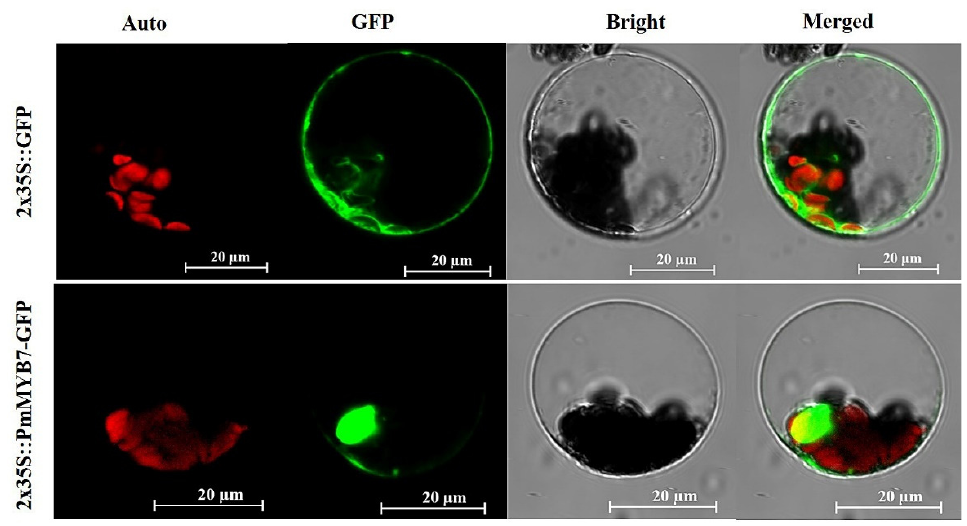
Figure 4. Subcellular localization analysis of 2x35S::PmMYB7-GFP in A. thaliana . The 2x35S::GFP was used as a control protein. Auto, chlorophyll autofluorescence; GFP, green fluorescent protein; Bright; Merged, GFP + Bright + Auto; Scale bar, 20 µ m.